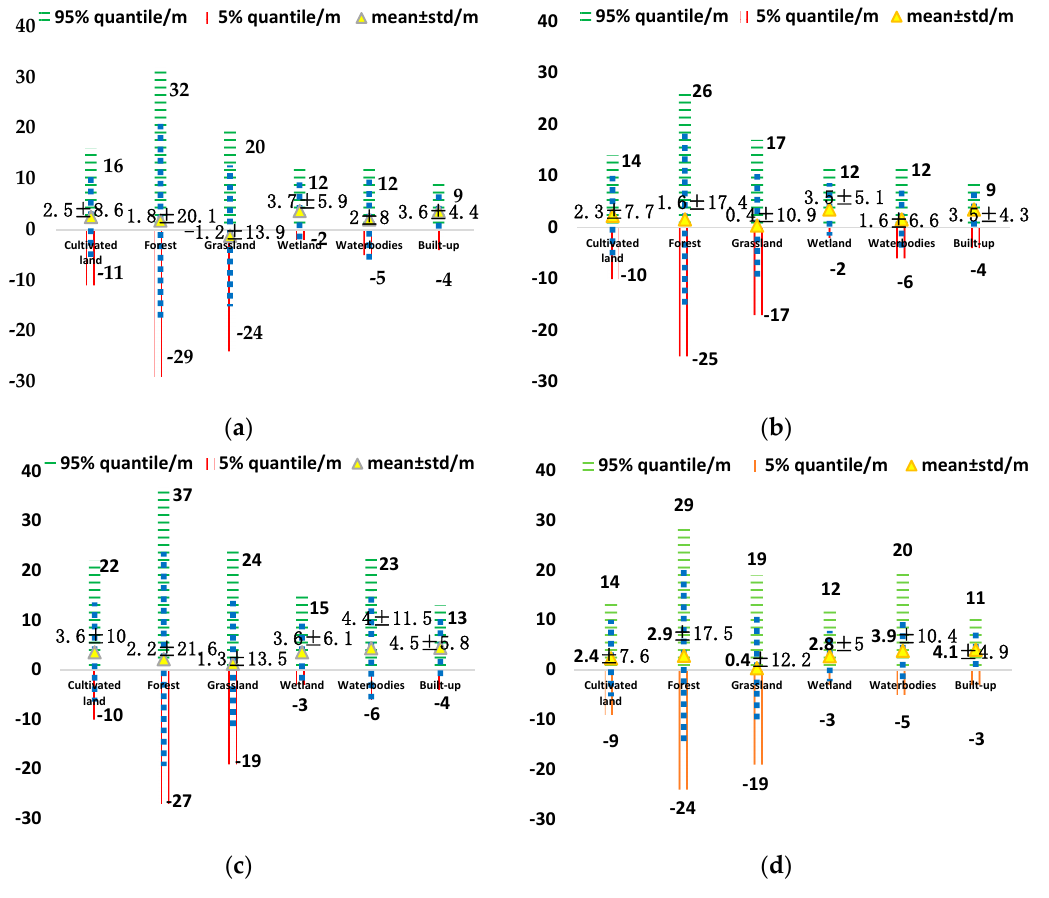
Figure 4. The DEM accuracy in different land covers for ( a ) SRTM 3; ( b ) SRTM 1; ( c ) ASTER GDEM; and ( d ) AW3D30.